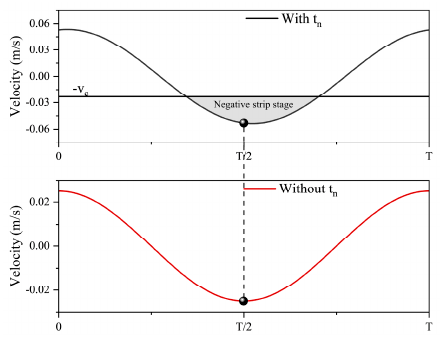
Figure 11. Oscillation velocity with and without t n